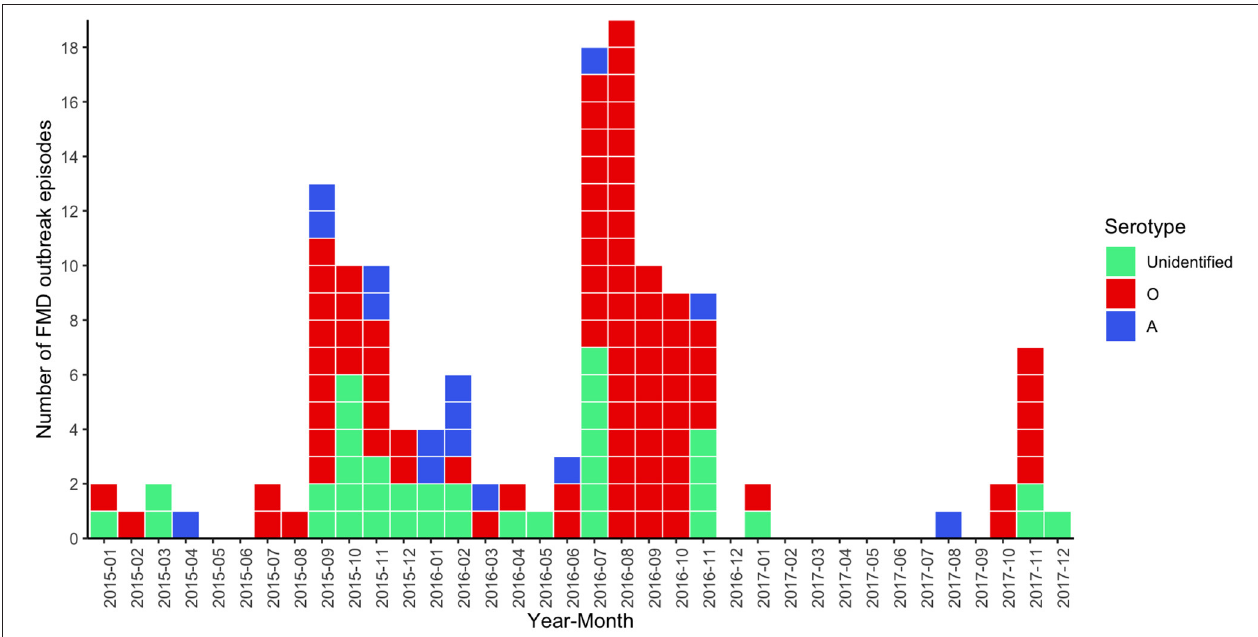
FIGURE 1 | Epidemic curve for FMD outbreak episodes caused by FMDV serotype O (red, n = 90), FMDV serotype A (blue, n = 15), and unidentified serotype (green, n = 37) in cattle in northern Thailand, 2015–2017.